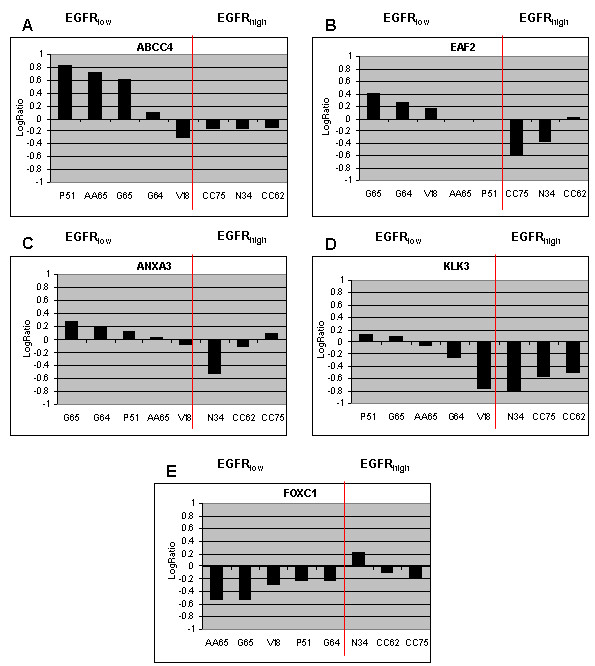
Different modulation of selected genes between mutated and EGFRlow (AA65, G64, G65, V18, P51) and mutated and EGFRhigh samples (N34, CC62, CC75) obtained by microarray analysis. A significant distinction between EGFRhigh samples and EGFRlow samples was found. (AA65, G64, G65, V18, P51, N34, CC62, CC75 referred to patients code as in additional file 1, table S1)